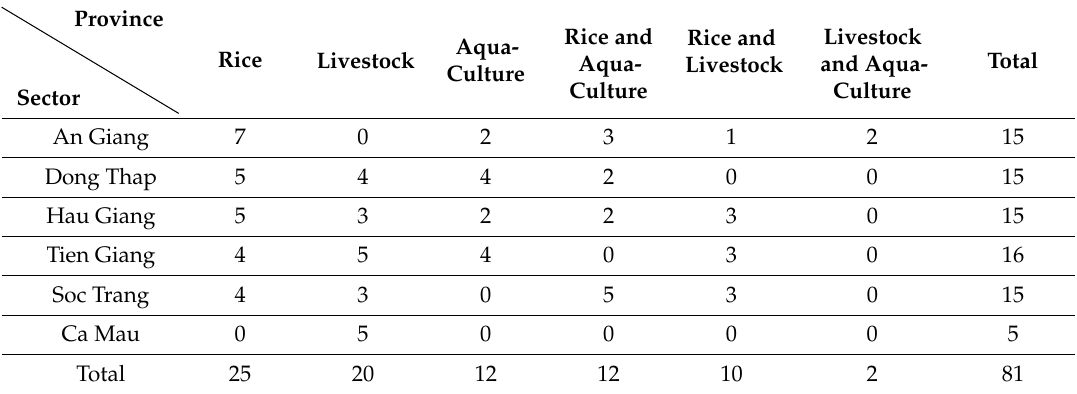
Table 3. Number of large farms surveyed by province and